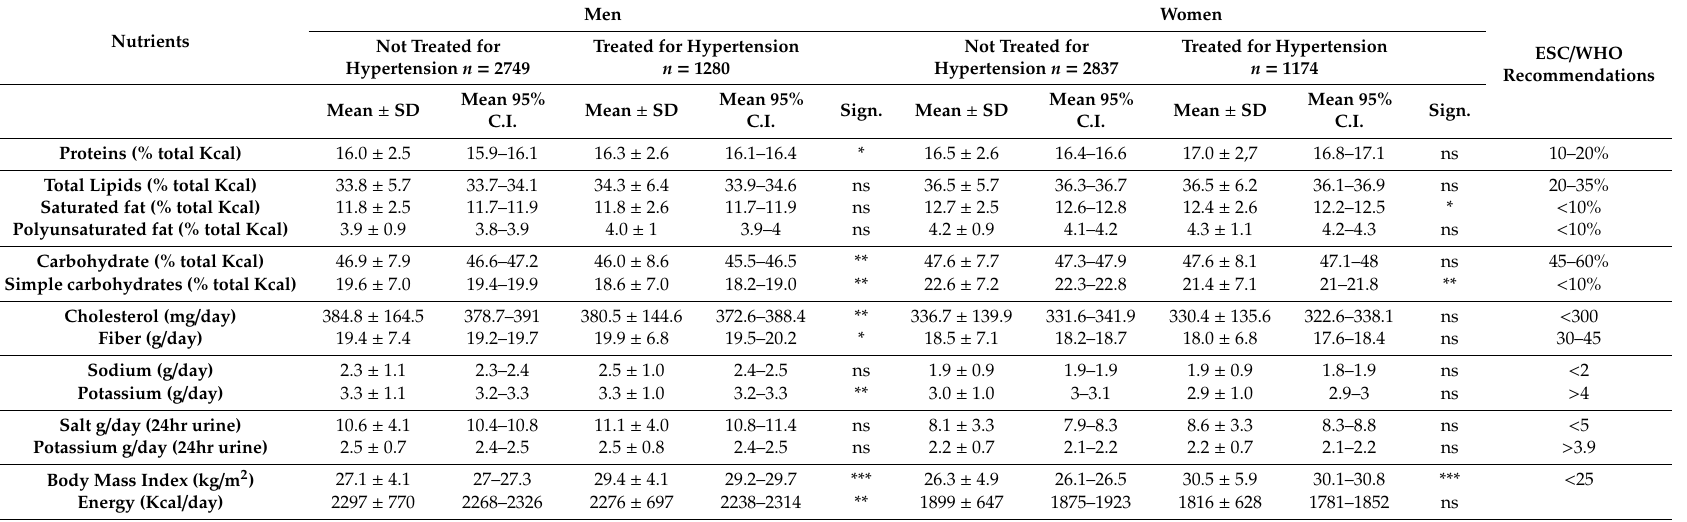
Table 1. Nutrients composition of diet in men and women receiving and not receiving treatment for hypertension. Men and women aged 35–79 years from the Osservatorio Epidemiologico Cardiovascolare / Health Examination Survey of the CUORE Project